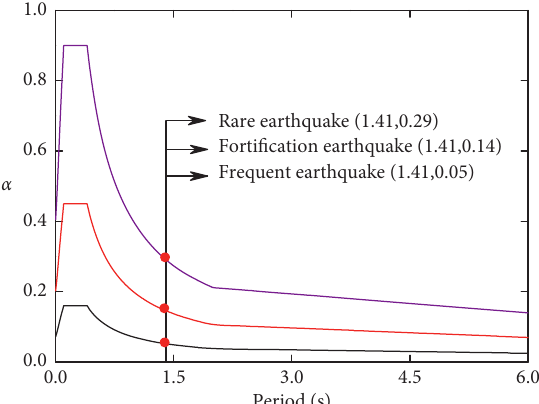
0.0 Figure 16: Spectral acceleration intensity of frequent, fortified, and rare